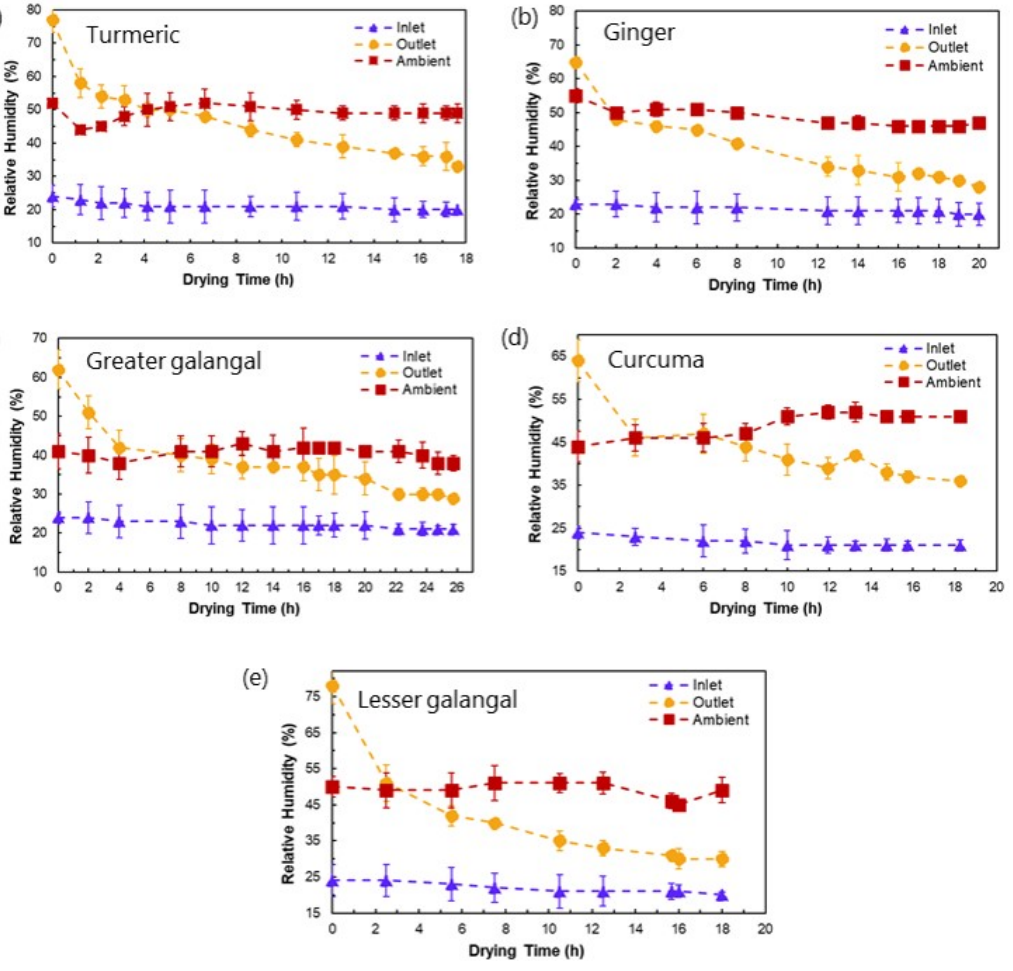
Figure 3. Relative humidity profiles of the ambient air and the drying cabinet in the Polydryer with the operation of a heater: ( a ) turmeric, ( b ) ginger, ( c ) greater galangal, ( d ) Curcuma, ( e ) lesser galangal.